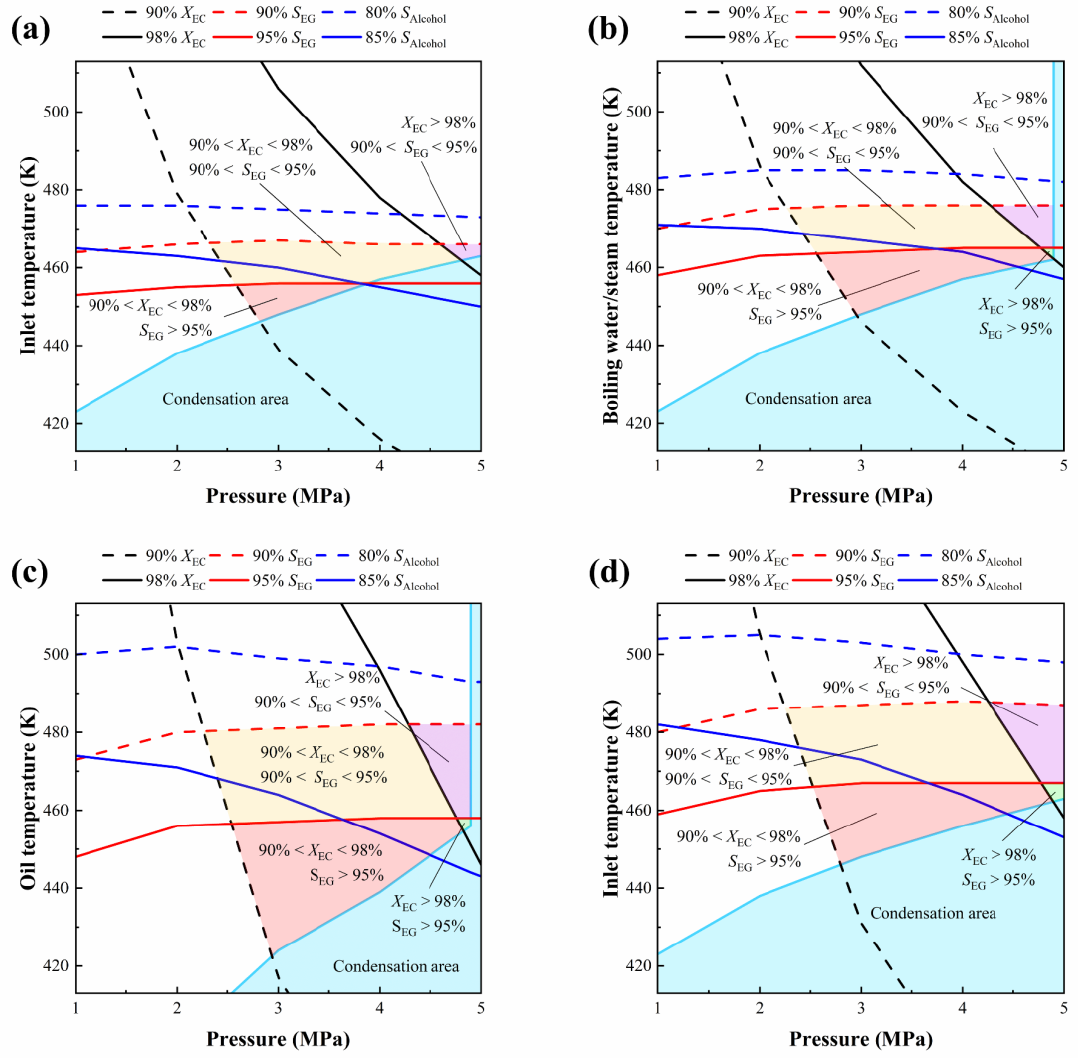
Figure 10. Operation windows of reactors for demanded T in / T c - P op parameters on outlet EC conversion, EG selectivity and total alcohol selectivity under SV = 0.3 g EC ·g cat − 1 ·h − 1 and H 2 /EC = 200. Reactor type: ( a ) adiabatic, ( b ) boiling water-cooled, ( c ) oil-cooled, T in = 463 K, ( d ) oil-cooled, T c = 453 K.